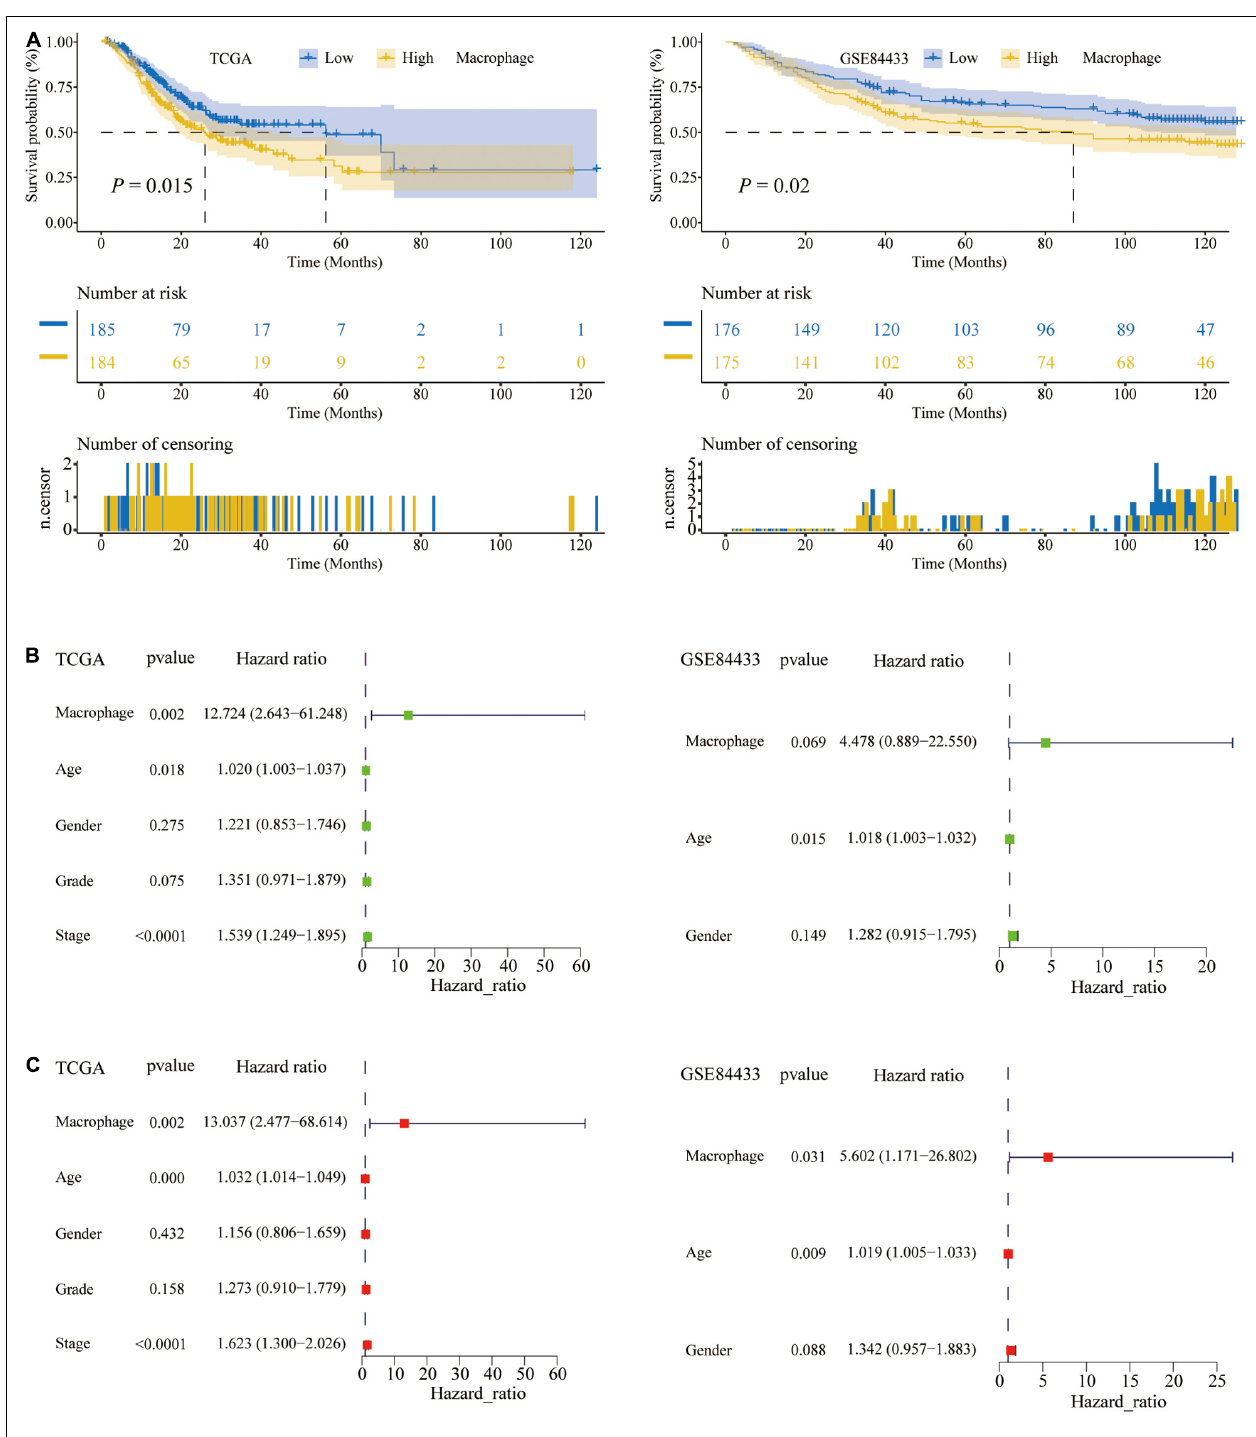
FIGURE 3 | The macrophage abundance was significantly related to the prognosis of STAD patients. (A) The higher the abundance of macrophages, the shorter the overall survival (OS) of STAD patients. (B) Univariate Cox regression analysis. (C) Multivariate Cox regression analysis.